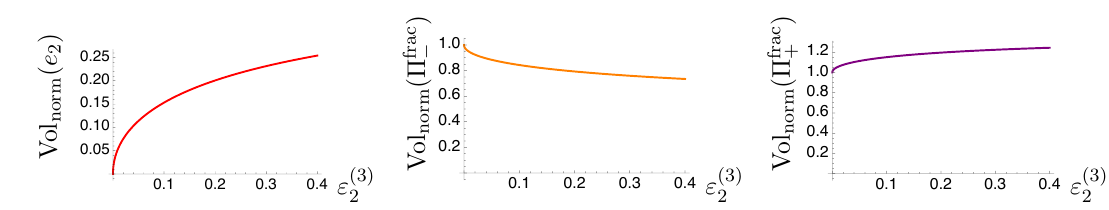
Figure 12 . Normalised volume of the exceptional cycle e (3)